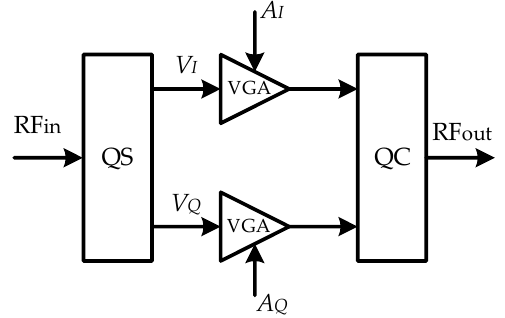
Figure 10. The circuit structure of IQ vector phase shifter.